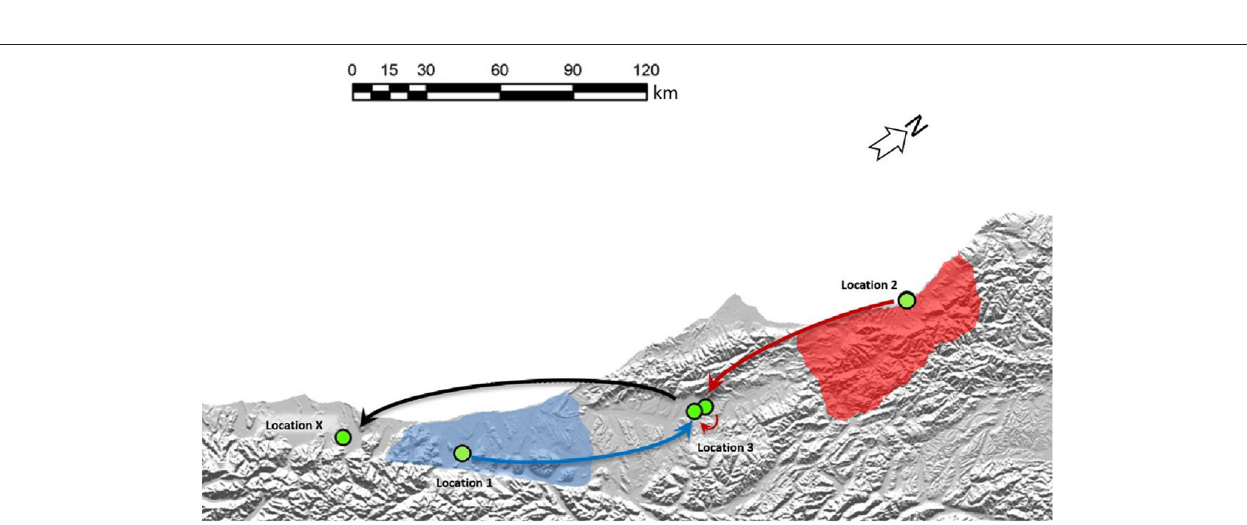
FIGURE 5 | Two separate origins of TB in a South Westland Herd. Cattle movements that led to these two types of infection in the South Westland herd are indicated by arrows. Green circles indicate approximate locations where these animals resided. Shaded areas on the map indicate regions where VNTR53/REA11/REA12 (red) and VNTR59/REA1/REA6 (blue) are endemic in wildlife populations. TB case 1 moved from Location 1 to location 3 before moving to Location X (from where it was identified as TB positive at routine slaughter). TB case 2 was moved from its herd of origin in location 2 to a farm near Location 3 before moving to location 3 and then on to Location X from where it was identified as being infected. The region described here is indicated by the black box in the map in Figure 2A .